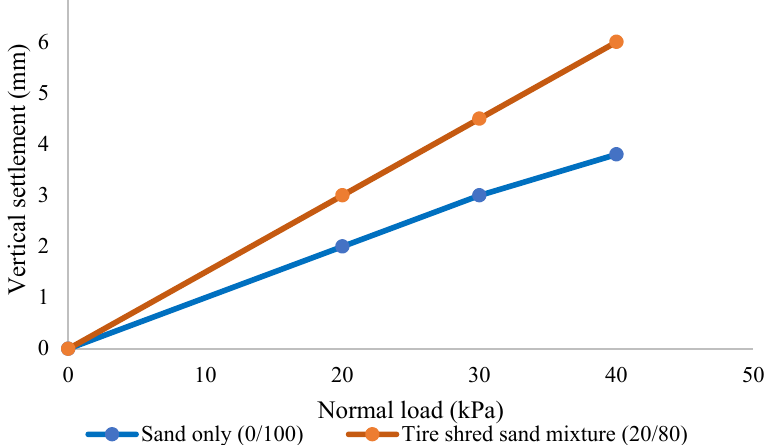
Table 4. Face deflection and max settlement for tire shred-sand mixture with reinforcement and for sand and reinforcement only. Load (kPa)